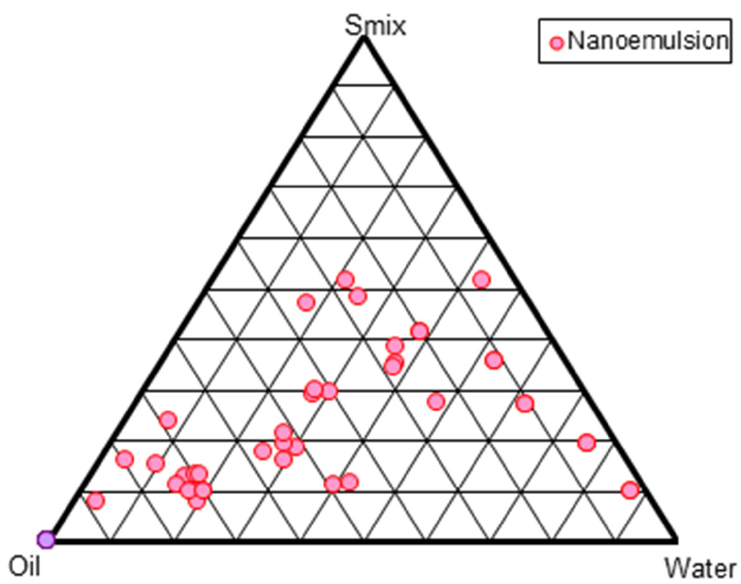
Figure 1. Pseudo-ternary phase diagram shown at S mix (surfactant-cosurfactant) ratio of 3:1.